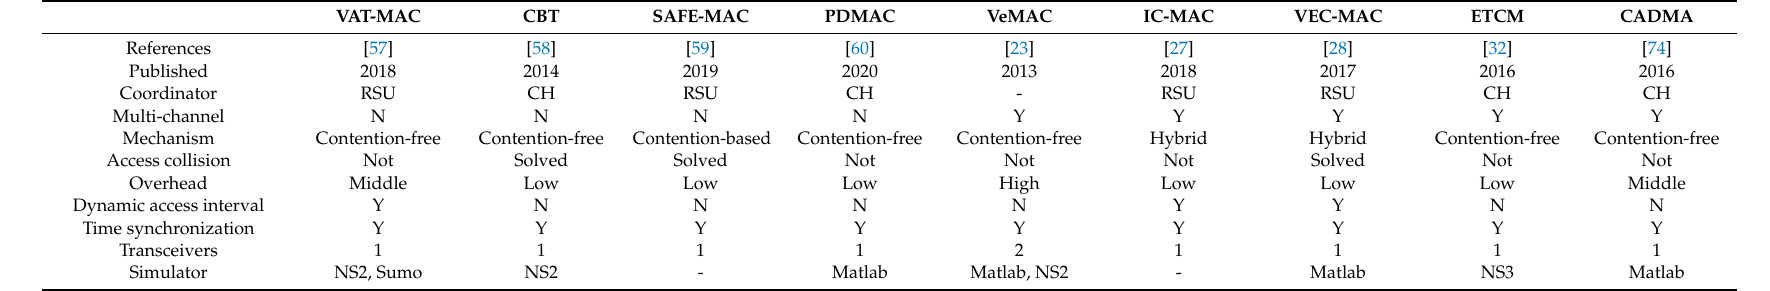
Table 3. Comparison of Centralized MAC